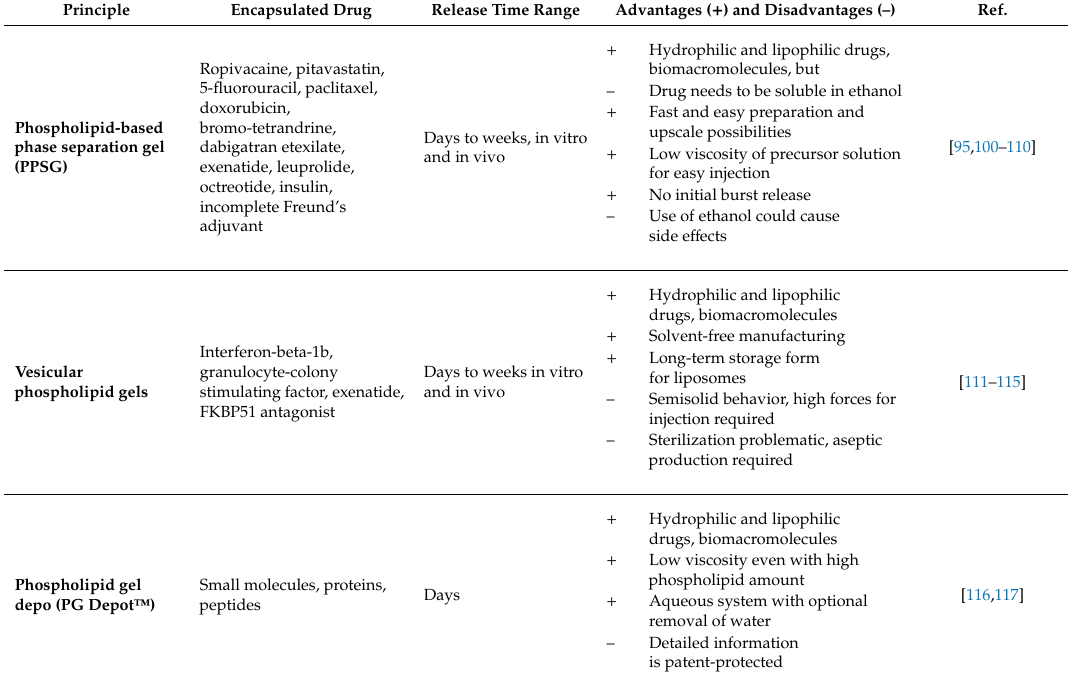
Figure 4. Overview of semisolid and in situ forming depot systems, for example phospholipid phase separation gels, vesicular phospholipid gels, or liquid crystalline phases. ( a ) Reprinted from [95]; ( b ) top image reprinted from [96]; ( b ) Bottom image reprinted from reprinted from [97]; ( c ) Left image reprinted from [98] with permission from Elsevier; ( c ) Right image published by The Royal Society of Chemistry [99]. Table 4. Overview of semisolid and in situ forming drug delivery systems.